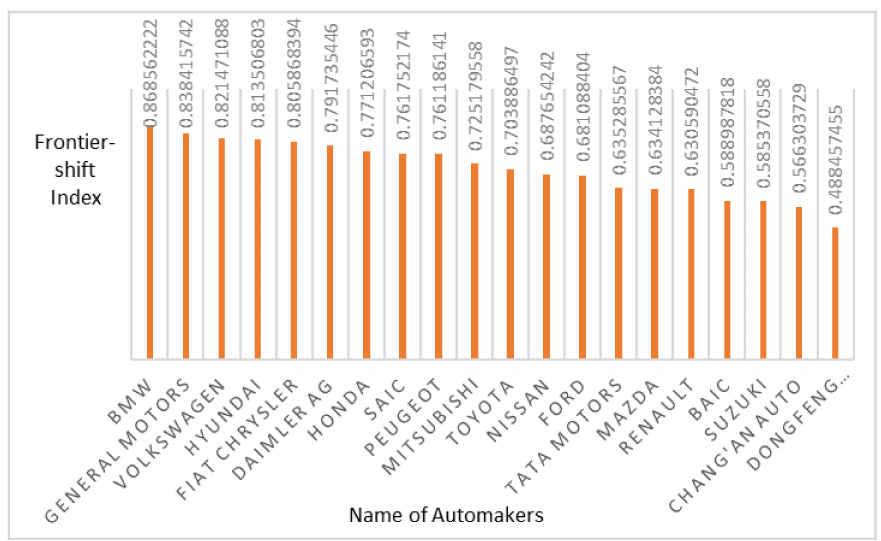
Figure 9. Frontier-shift index of automakers in 2017–2018 period.